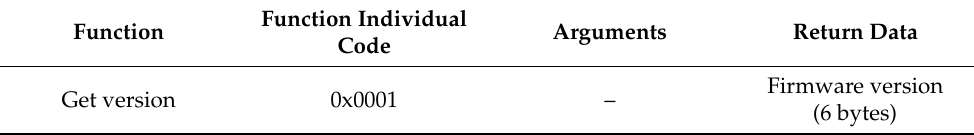
Table 7. CAN transaction for reading AFE firmware version.